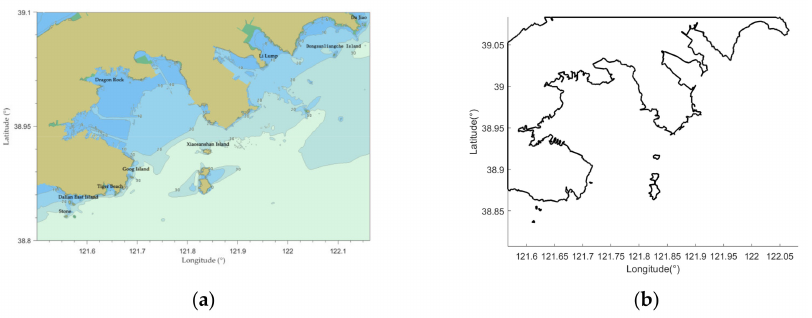
Figure 5. ( a ) The S-57 Electricity Chart. ( b ) The coastline data was extracted from the S-57 electric- ity